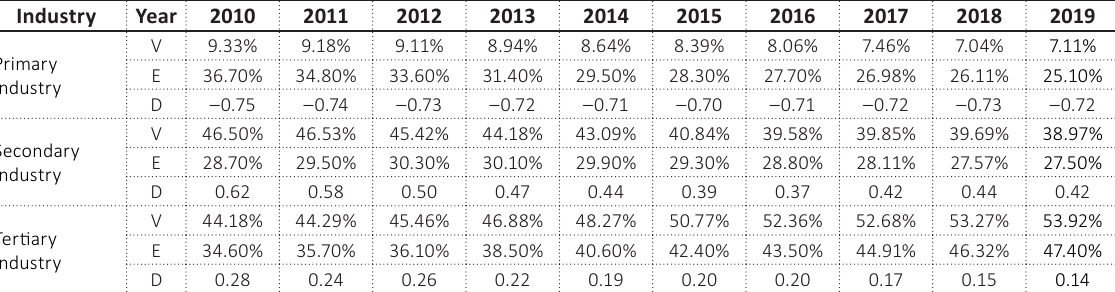
Table 2. Deviation coefficient of the employment structure in various industries in China